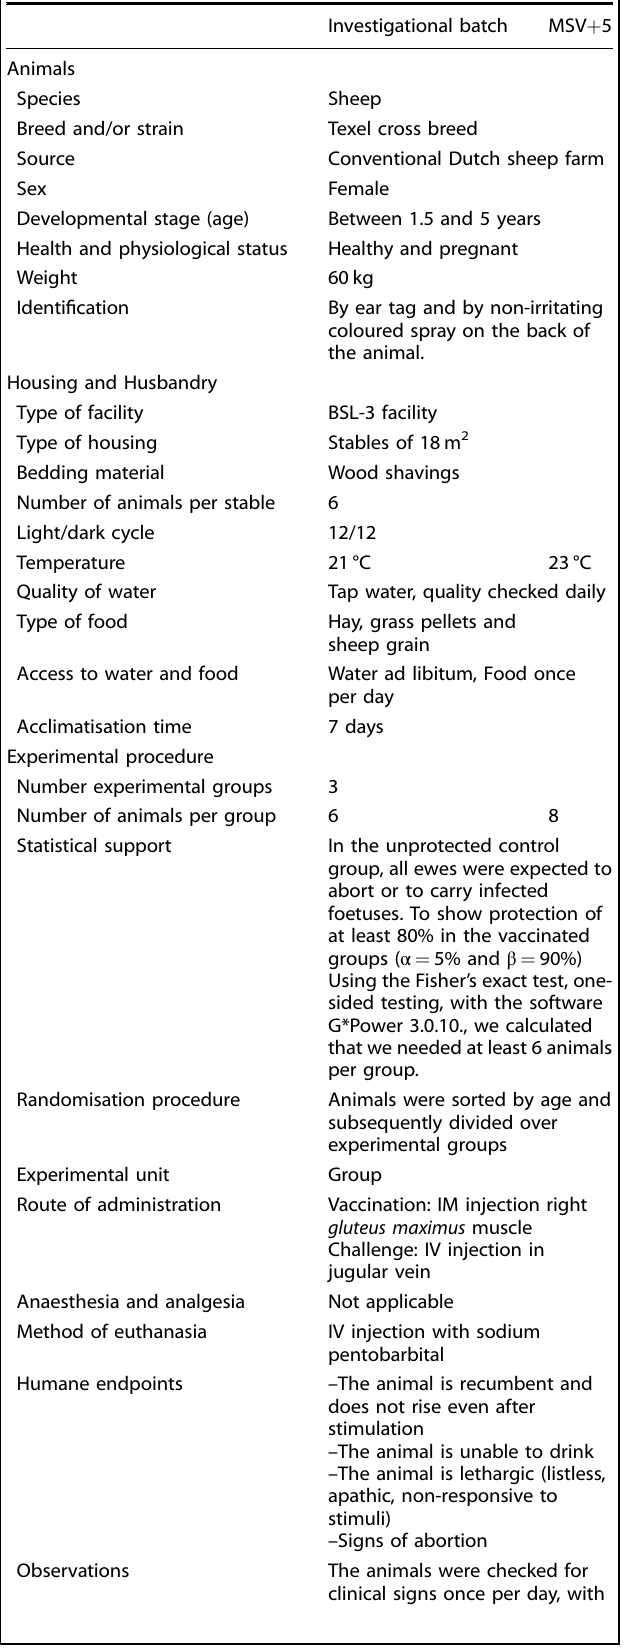
Table 1. Experimental details according to the ARRIVE